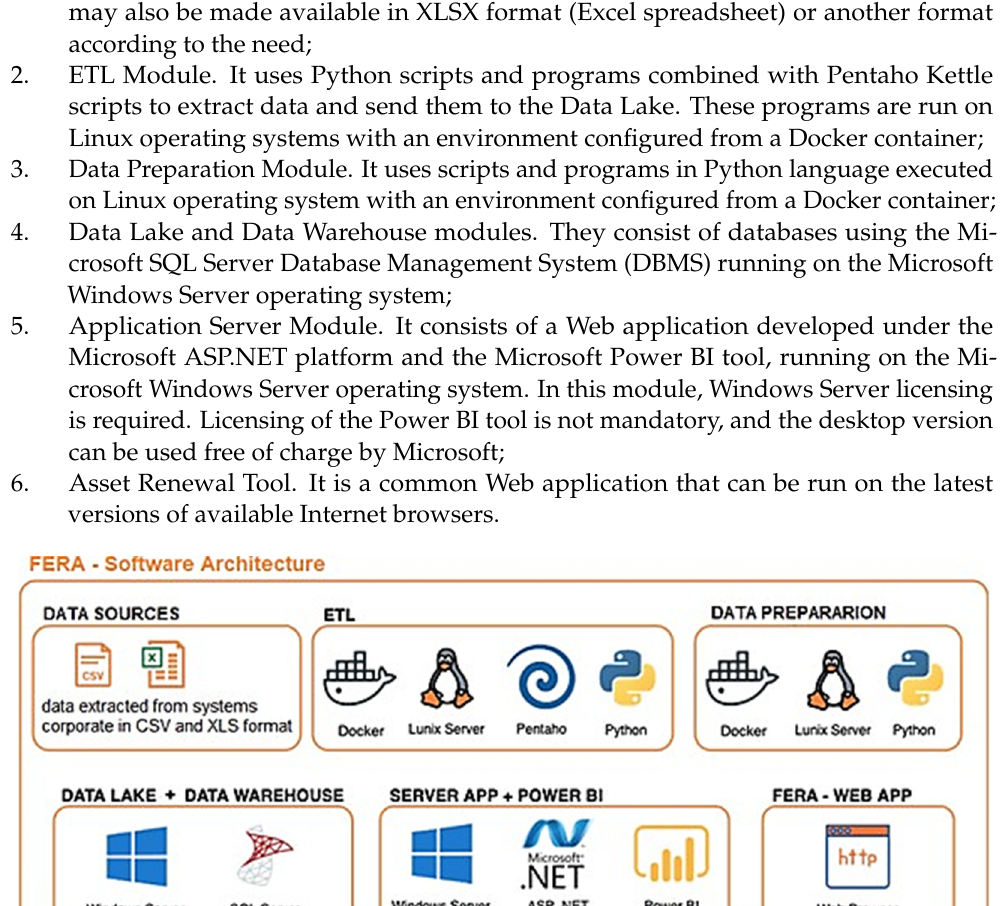
Figure 20. View of the hardware architecture used to execute the components of the FERA [authors]. The tool was developed using a cloud architecture where the hardware infrastructure and network services are configured in a more flexible way, allowing their adaptation in a more simplified way. To make the tool available in the ”on premises” format, it was necessary to configure the hardware infrastructure by COPEL’s IT area. The hardware components for running the tool are: 1.